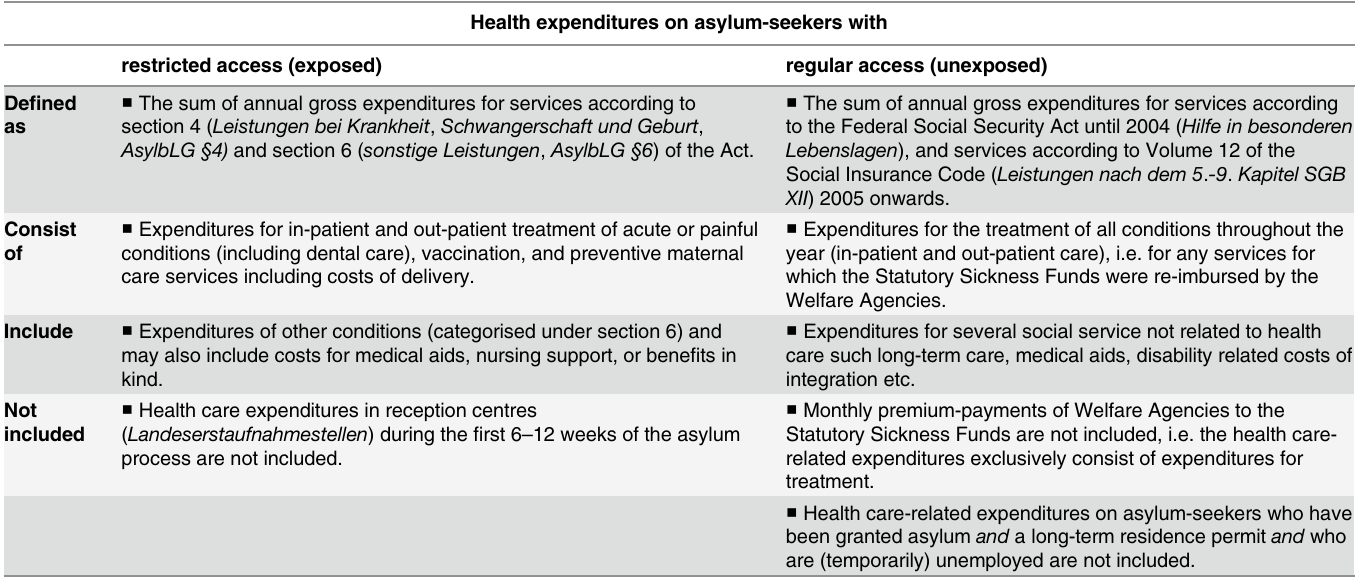
Table 1. Type of officially reported expenditures used to calculate health expenditures among asylum-seekers with restricted and regular access to health